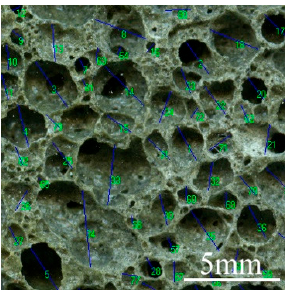
Figure 2. Statistical analysis on aperture size of foam glass samples.